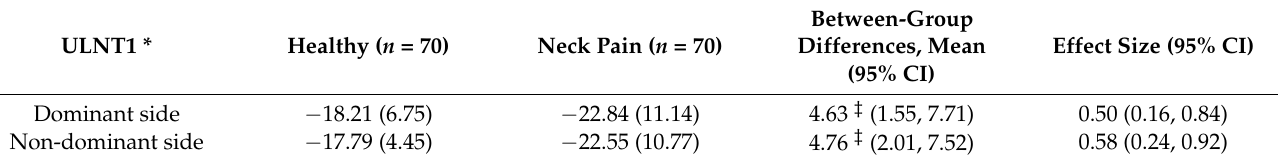
Table 3. Between-group differences in the upper limb neural tension test measurements